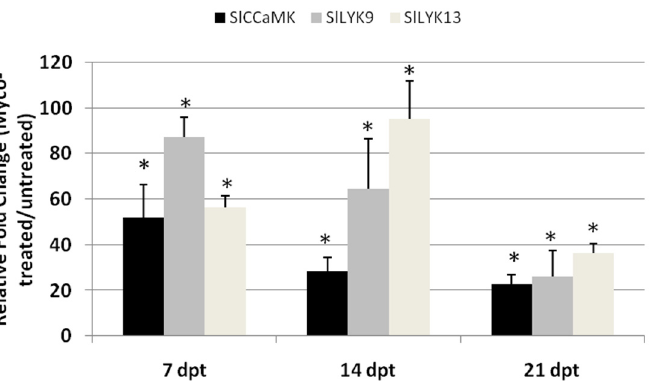
Figure 4. Expression of SlCCaMK , SlLYK9 , and SlLYK13 genes in tomato roots after treatment of plants with Myco2. Expression of genes was detected by quantitative real-time reverse-transcription polymerase chain reaction (qRT-PCR) in roots of tomato plants at 7, 14, and 21 days post-treatment (dpt). Data are the mean fold changes ( n = 6) ± SD in gene transcript levels of roots from Myco2- treated plants relative to those from untreated control plants (the value 1 indicates no change). An asterisk (*) indicates that the mean fold change is significantly different from 1 as determined by the non-parametric Kolmogorov–Smirnov test ( p <